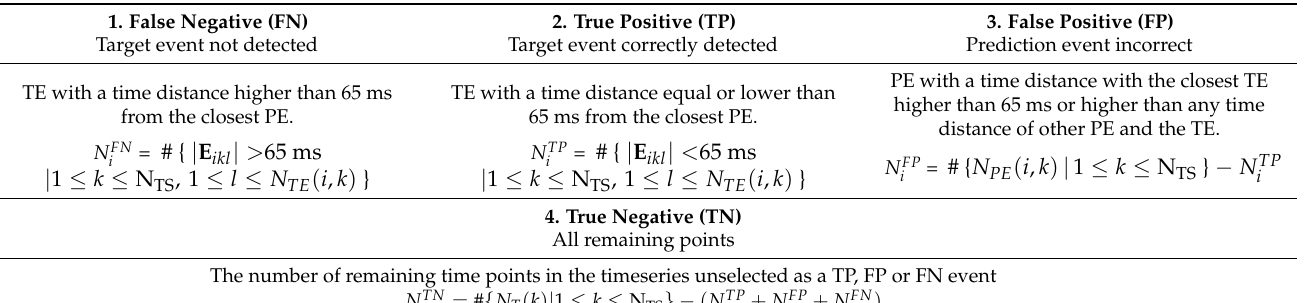
Table 3. Classification of the target events (TE) and the prediction events (PE) for FN, TP and FP. 1. False Negative (FN) 2. True Positive (TP) Target event not detected Target event correctly detected